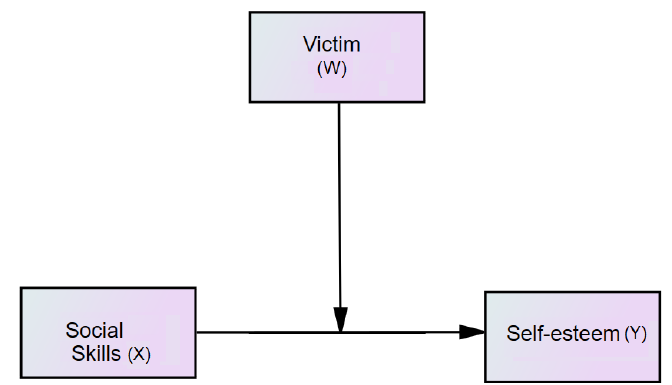
Figure 1. Moderation model of social skills.